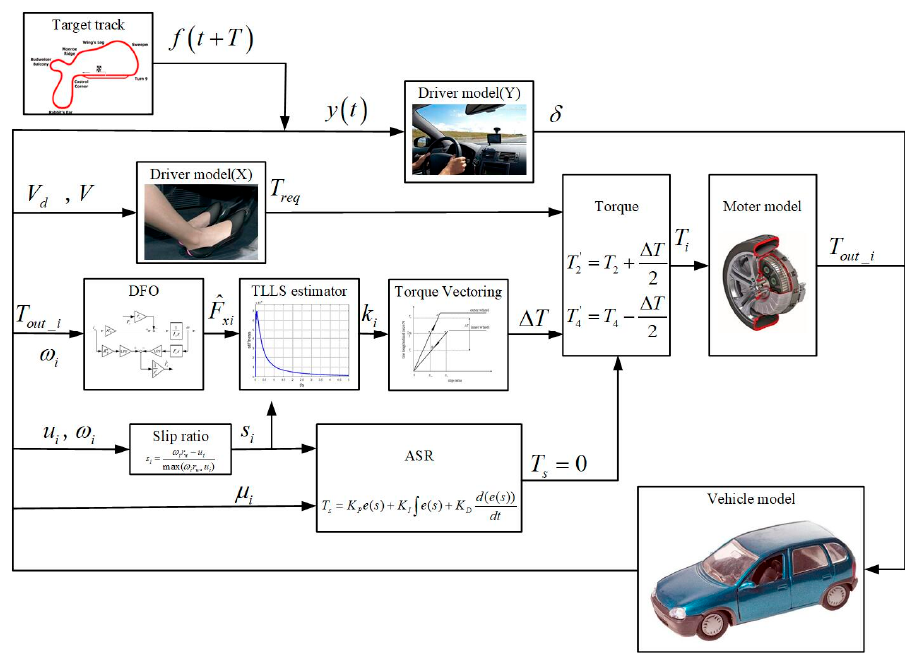
Figure 6. The overall diagram of torque vectoring control strategy.